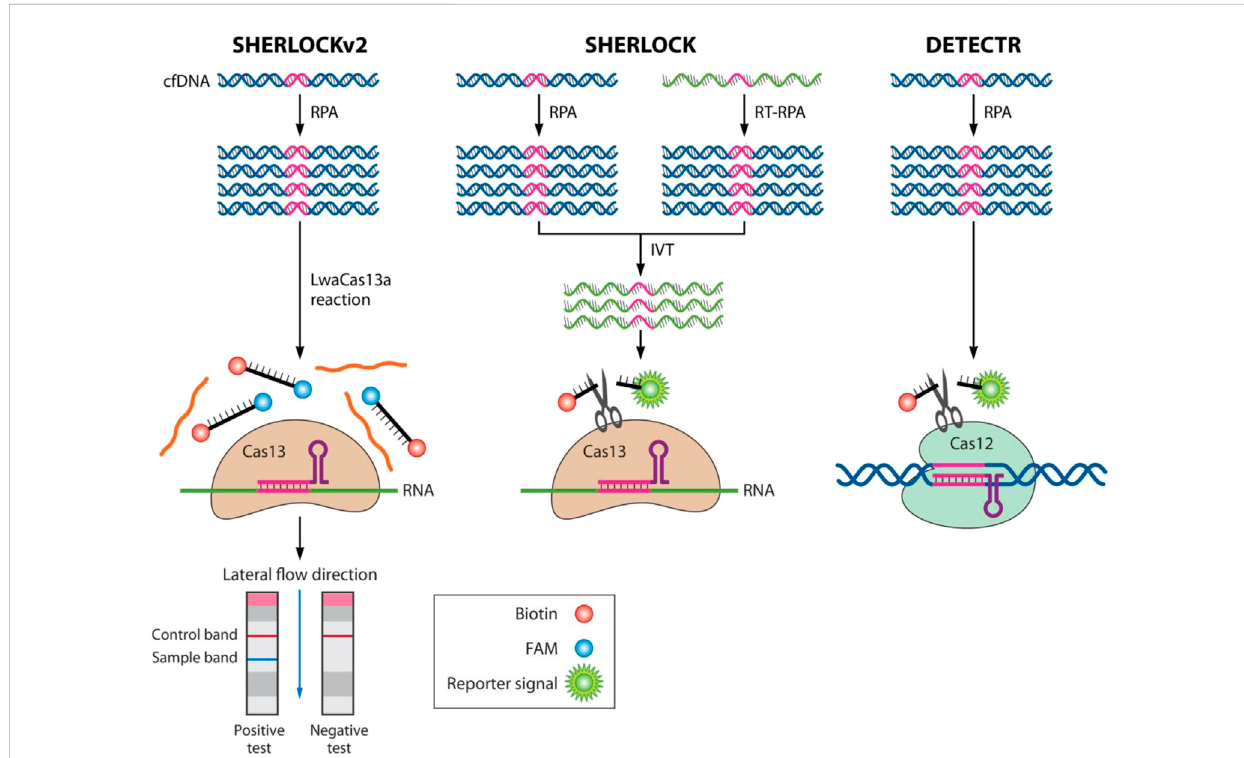
CRISPR-Castechnologiesfornucleicaciddetection inSHERLOCKv2,SHERLOCK,andDETECTRassays.Intheabsenceofitsnucleicacidtarget,the Cas nuclease is inactive. When binding to its guide crRNA to a related target (RNA for Cas13a, ssDNA or dsDNA for Cas12a), the nuclease is activated, leading to catalytic cleavage of off-target nucleic acids (RNA for Cas13a, ssDNA for Cas12a). This collateral nuclease activity is turned into an ampli fi ed signal by providing reporter probes with a fl uorophore (green) linked to a quencher (white) by a short oligonucleotide (black). (Left) Schematic of SHERLOCKv2, withdirectdetection ofviralinfection(forexample)inbodily fl uids.(Middle)SchematicoftheSHERLOCKsystem.Nucleicacidisextracted from clinical samples (for example), and the target is ampli fi ed by recombinase polymerase ampli fi cation (RPA) with either RNA or DNA as the input (reverse transcriptase recombinase polymerase ampli fi cation [RT-RPA] or RPA, respectively). RPA products are detected in a reaction mixture